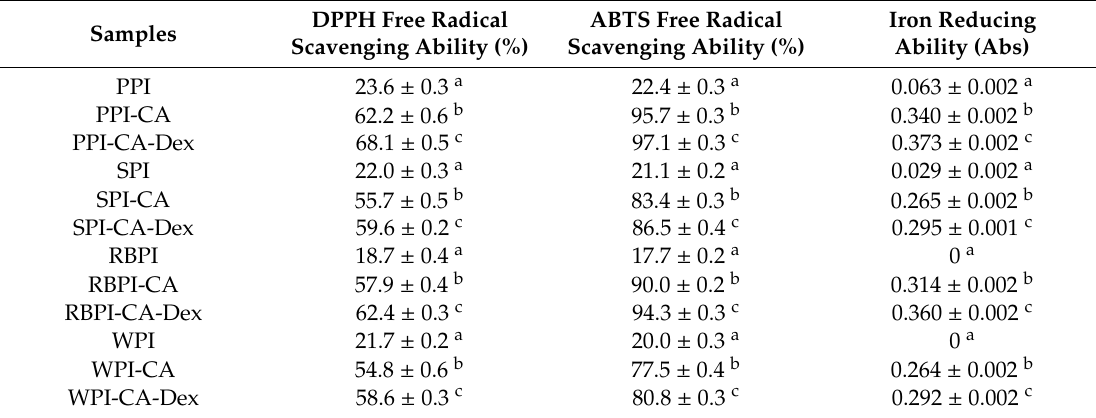
Table 2. 1,1-Diphenyl-2-picrylhydrazyl radical 2,2-Diphenyl-1-(2,4,6-trinitrophenyl)hydrazyl (DPPH) free radical scavenging activities, 2,2 (cid:48) -amino-di(2-ethyl-benzothiazoline sulphonic acid-6)ammonium salt (ABTS) free radical scavenging activities, and the iron reducing ability of NP, PC, and PCD samples.